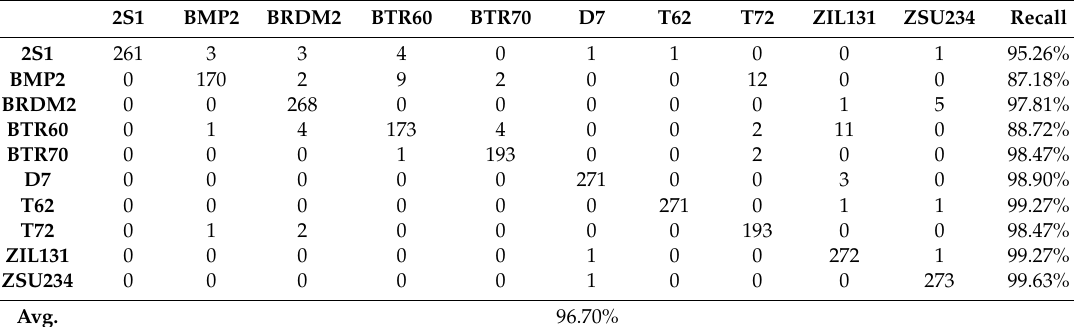
Table 3. Confusion matrix of the MSTAR dataset using gcForest.